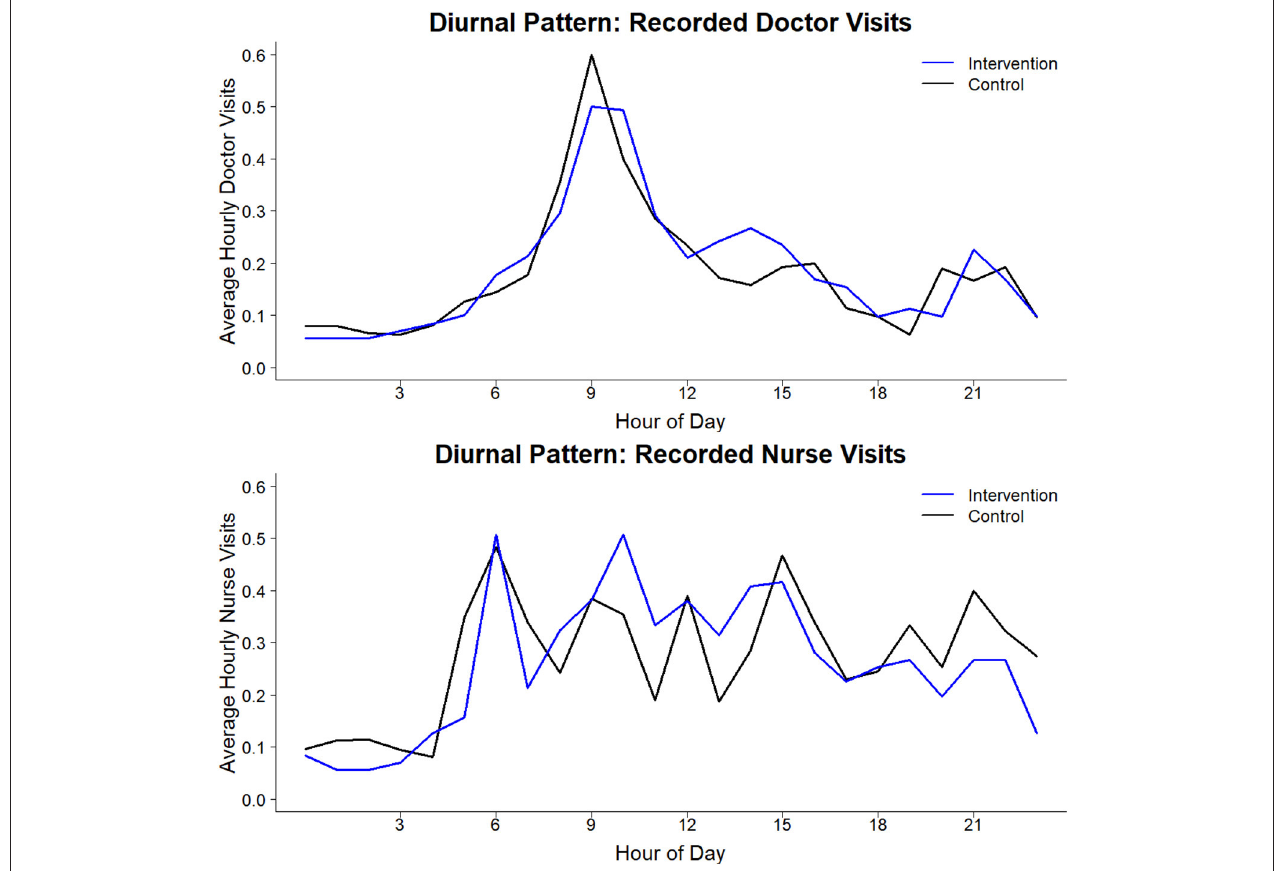
FIGURE 3 | Daytime pattern of clinician patient visits in intervention vs. control